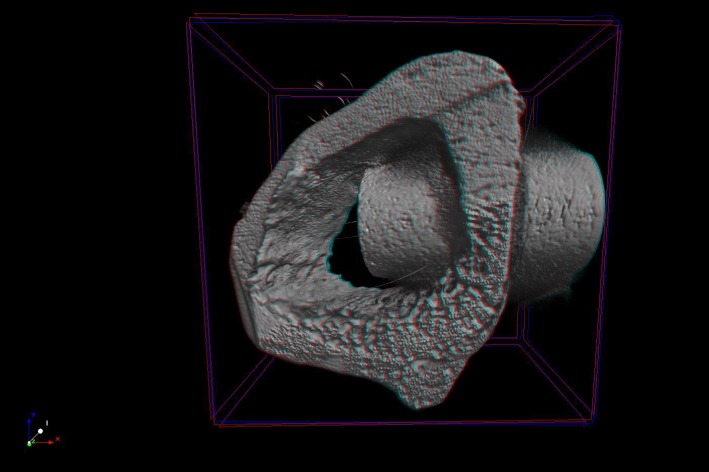
3D representation of micro-computed tomography.Image of implant and bone around implant at 4 weeks.